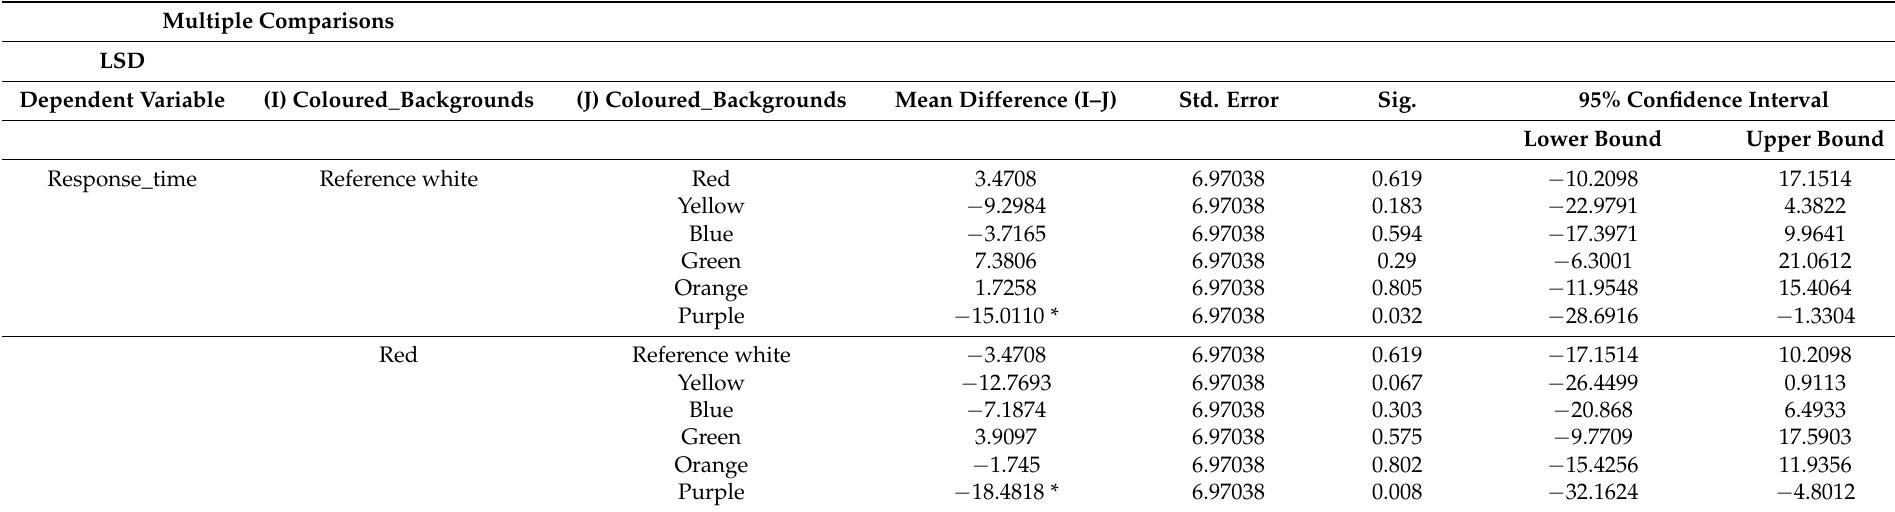
Table A5. Multiple Comparisons of People’s Responses to Colours—General